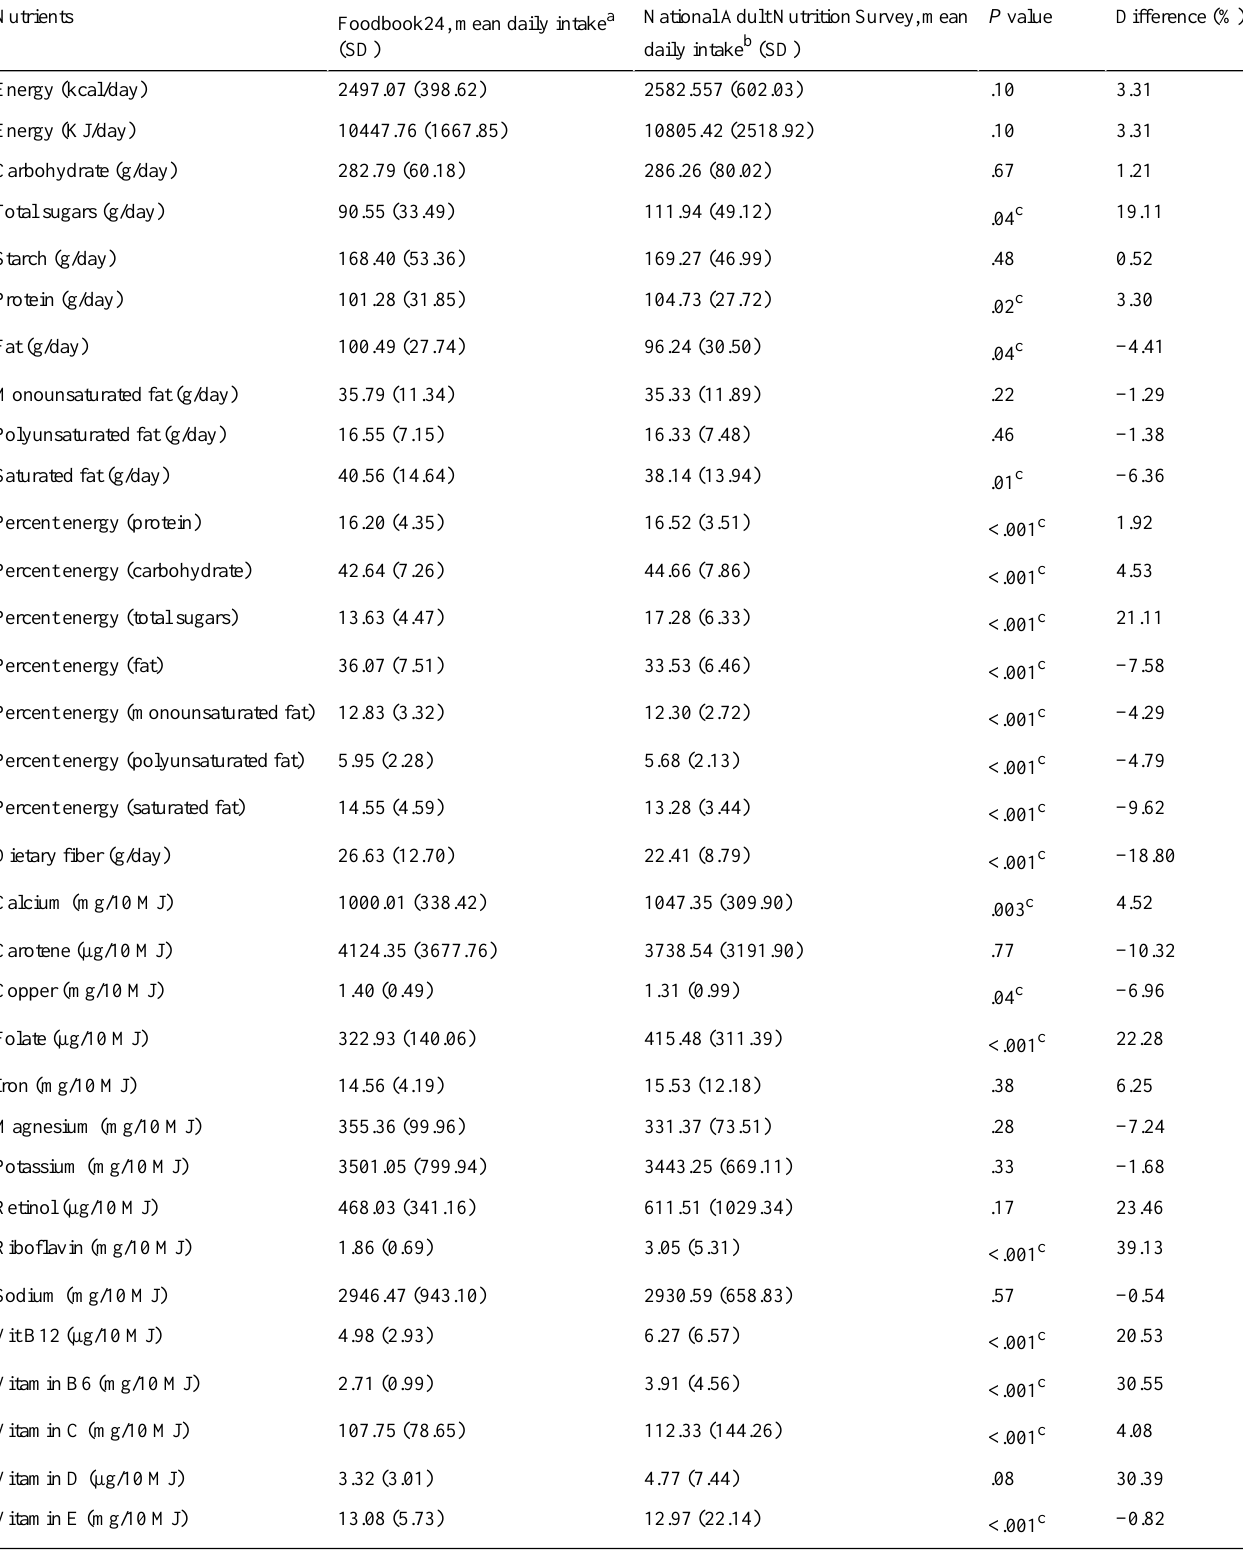
Table 4. Nutrient intakes of male adequate reporters from the Foodbook24 web-based study (2016) and the National Adult Nutrition Survey (2011).